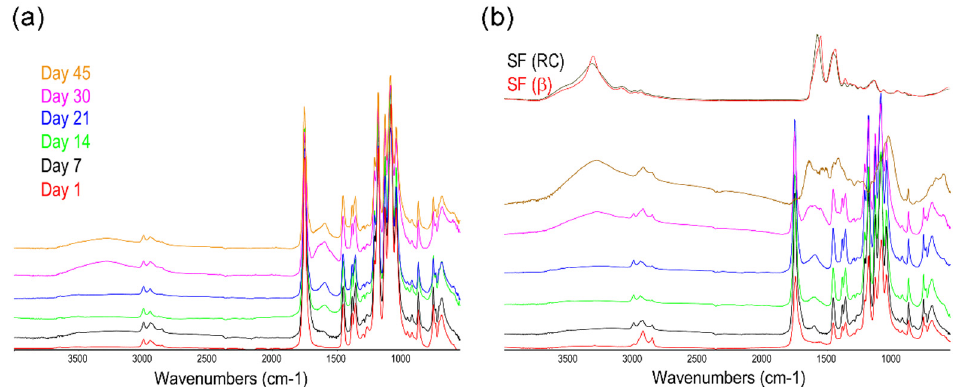
Figure 11. Comparative evolution of the ATR-FTIR spectra along the incubation at composting conditions: Full spectra of the PLA from day 1 to 45 ( a ) and PLA-MCO-CS from day 1 to 45 ( b ). Pure fibroin in random coil (RC) or β -sheet ( β ) conformation is inserted for comparison purposes. Comparatively, the PLA spectra showed an increase in the signal of a broad band centered at 1600 cm − 1 , which is related to the presence of carboxylate ions in degraded PLA [63,64]. The spectra of silk fibroin nanoparticles, mainly in a β -sheet, highly crystal- line conformation (amide I at ~1626 cm − 1 and amide II at ~1520 cm − 1 ), and the regenerated silk fibroin (non-crystalline or Silk I), which was mainly in a random coil (RC) confor- mation (amide I at ~1650 cm − 1 and amide II at ~1538 cm − 1 ), are presented in the figure as a reference. In silk composites, the signals are composed by the sum of the contributions of the random coil and β -sheet conformations. This behavior could be explained by the fact that the decomposition of the PLA facilitates the emergence of the signals corresponding to the crystallized silk fibroin (highly ordered, insoluble, and stable) present in the com- posites from the background of the PLA spectrum. However, the fibroins have also been partially decomposed during this incubation into soluble peptides, mainly in a “random coil” conformation, giving a combination of both signals in the spectra with wider Amide I and II bands. 4. Conclusions Corn oil was successfully maleinized (MCO) and used together with different silk particles as PLA modifiers. The low intrinsic elongation at break of PLA (1.7%) was im- proved by adding MCO-CS (23.7%), MCO-SFM (8.8%), and MCO-SFN (10.8%). Field emission scanning microscopy (FESEM) reveals a good miscibility between PLA and MCO and a good dispersion of all the silk particles used. The glass transition temperature is reduced by incorporating the silk particles and the crystallinity increases. Based on UV absorption results, silk particles act as UV light shields in PLA. The results obtained in this work suggest that an environmentally friendly plasticized PLA can be obtained using maleinized corn oil with 0.5 phr silk-based materials crushed silk, silk fibroin microparti- cles, or nanoparticles). The authors have identified the process of dispersion of the parti- cles in the oil as a limitation of the study since the amount of MCO that can be added to PLA for the optimal plasticizing effect is limited. Consequently, the amount of nano and microparticles that can be homogenously dispersed with this technique is also limited. Interestingly, these silk-based fillers introduced different mechanical and thermal properties to the composites, which offer a wide range of combinations for customizing the properties by changing the composition of the PLA. Indeed, the successful composting test guarantees the disintegrable nature of the formulations studied and results agree with previous studies. Finally, further studies focused on obtaining new biocomposites have been carried out, by either testing alternative fillers or new formulation methods, both focused in to overcome the limitations of the study and increase the knowledge in this dynamic field.